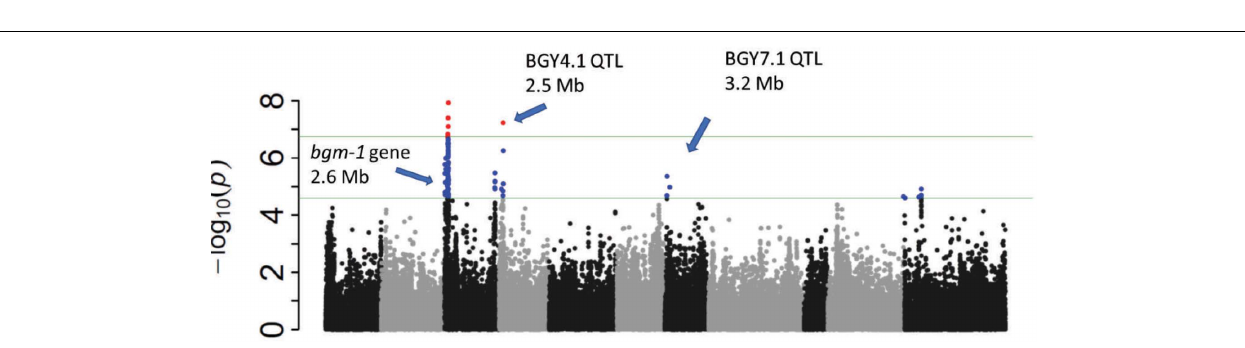
FIGURE 4 | Manhattan plot from GWAS ( Supplementary Table 3C ) in BASE_120 evaluated for % infection in Honduras in 2014. Tepary and Andean beans were excluded.